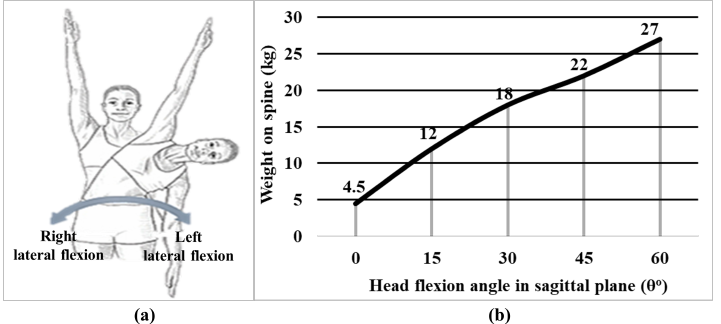
Figure 3. Estimated characteristics of the IMU sensor ( a ) lateral flexion of human posture and ( b ) relationship between the head flexion angle in sagittal plane ( θ ) and weight (kg) imposed on